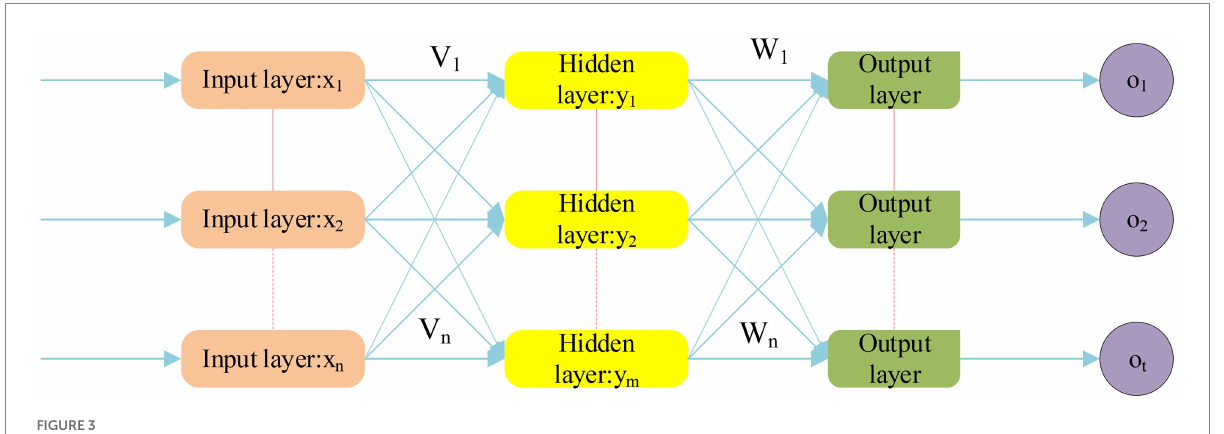
FIGURE 3 Forward propagation stage of BPNN